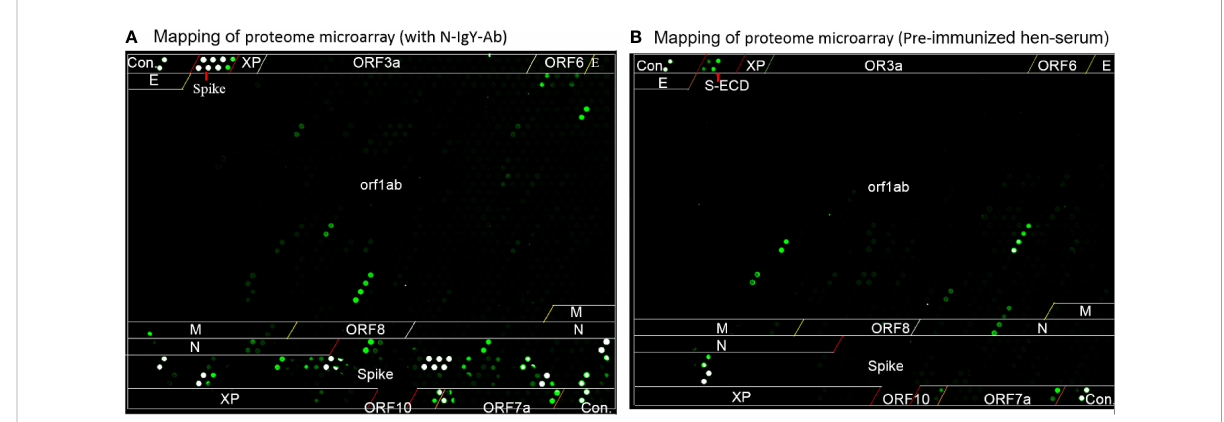
FIGURE 5 The mapping of proteome microarray. (A) the puri fi ed N-IgY-pAb binding peptides or proteins of SARS-CoV-2 protein, (B) Serum of the pre- immunized